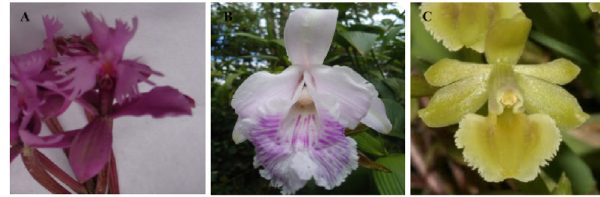
Figure 1. Orchids used for cryopreservation tests. A ) Epidendrum quitensium, B ) Sobralia rosea, C ) Epidendrum